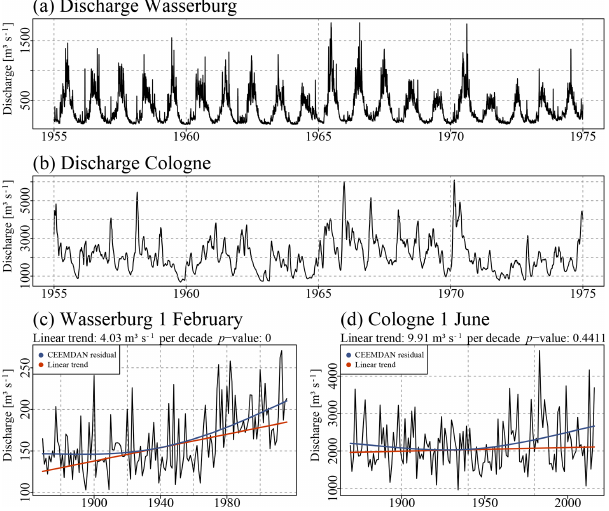
Figure 2. Discharge recordings from gauges Wasserburg (a) and Cologne (b) and measurements from all 1 February/1 June days for gauge Wasserburg/Cologne after applying a 30d moving average filter over the entire time series (c, d) . The robust Theil–Sen trend estimator and the Mann–Kendall trend test were applied to assess the magnitude and significance of the linear trends (red line). The CEEMDAN residual is used to extract the non-linear evolution of the trend (blue